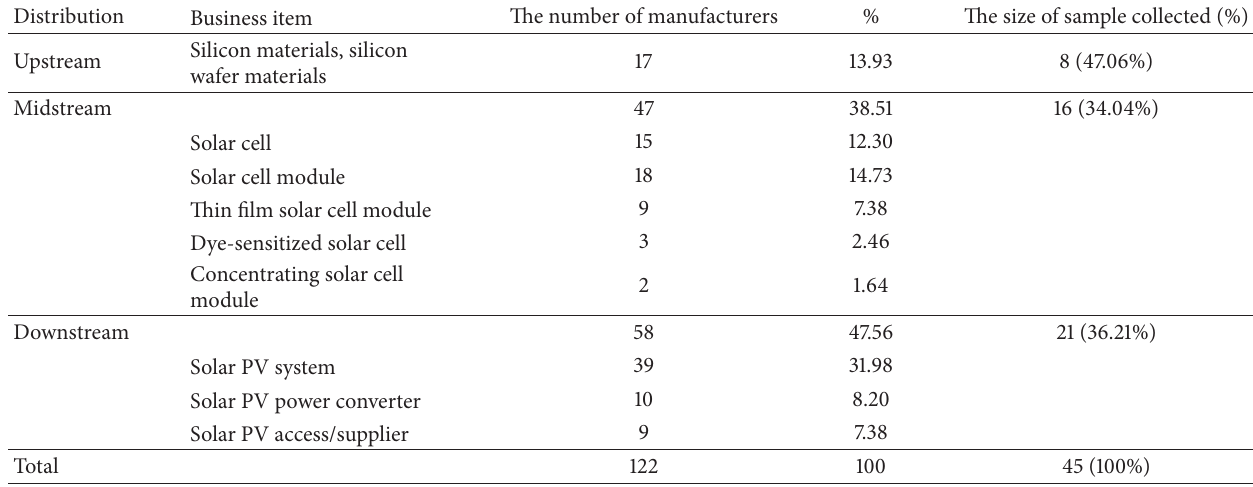
Table 1: The expert sampling list of Taiwan’s solar